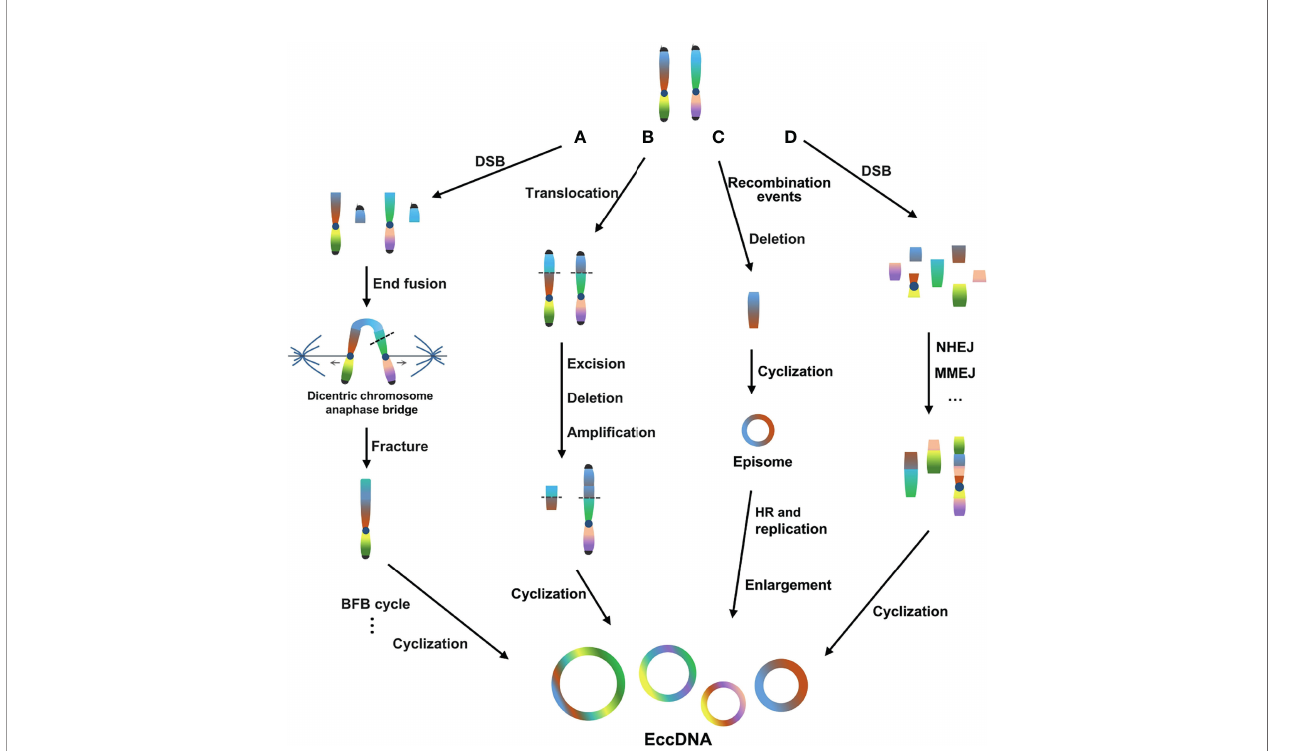
FIGURE 1 | Four main models of eccDNA formation. (A) BFB cycle model. The BFB cycle begins with DSBs, where the ends of the broken chromosomes fuse to form dicentric chromosomes and anaphase bridges. Chromosomal bridge breakage at anaphase produces new ends lacking telomeres, triggering another round of ampli fi cation in the BFB cycle. (B) Translocation-excision-deletion-ampli fi cation model. Multiple DSB events trigger the formation of reciprocal translocations, and fragments near the translocation breakpoint can be ampli fi ed, excised, deleted, and circularized. (C) Episome model. The generation of episomes should be associated with the deletion of the chromosomal sequence corresponding to the recombination event. Episomes may be expanded by HR and duplication. (D) Chromothripsis model. DSBs occur on one or more chromosomes and then randomly recombine and circularize through DNA repair mechanisms such as NHEJ and/or